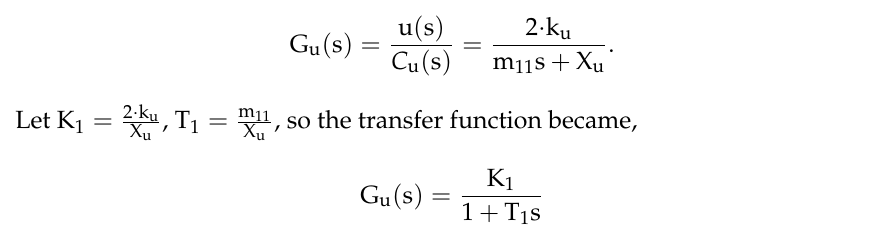
Figure 7. The relationship between thrust τ 1 and the basis control variable C u . The transfer function for the speed u and the basis control variable C u , were acquired by the Laplace transformation based on Equation (14),